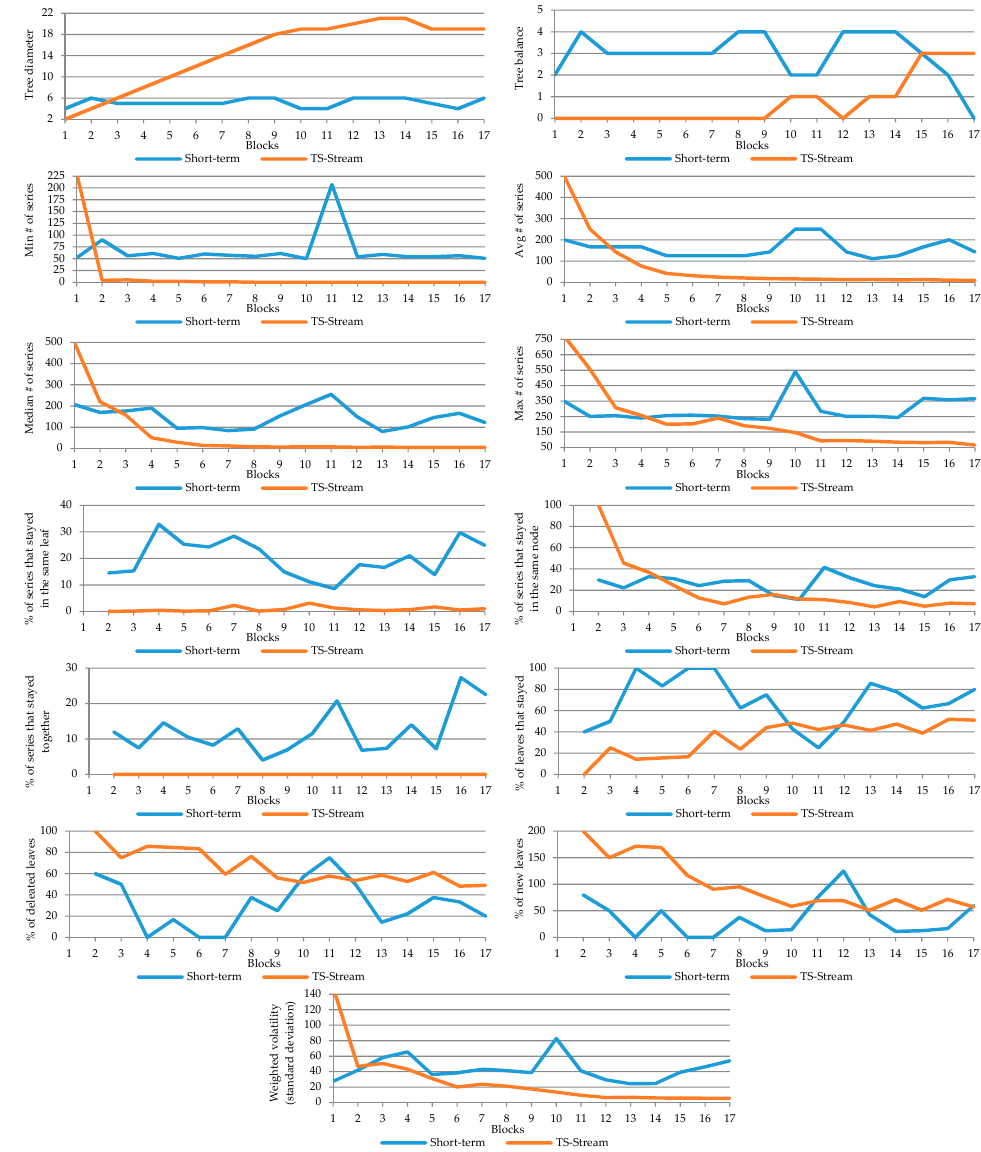
Figure A7. Detailed results for 𝑚𝑖𝑛𝑆𝑒𝑟𝑖𝑒𝑠 set at 5% and window length 𝑤 set at 30 days for basic TS-Stream algorithm.